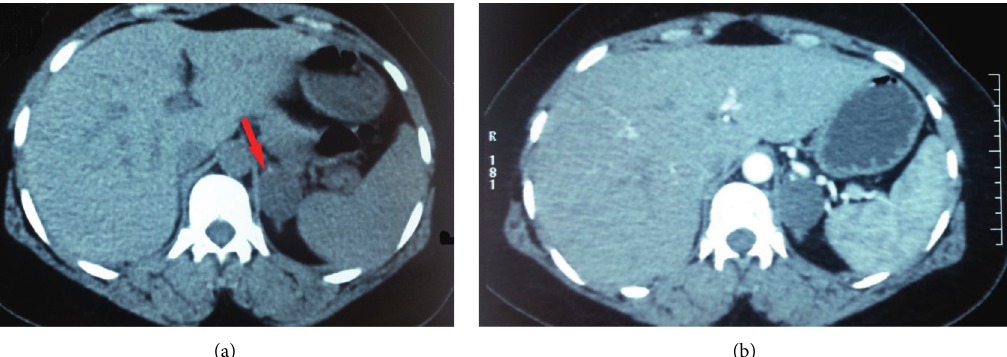
Figure 1: Unenhanced computed tomography scan (a) of the abdomen showing a unilocular left adrenal cyst, without wall’s enhancement after contrast injection (b). Table 2: Comparative table of laboratory data before and after surgery. Before surgery 3 months after surgery